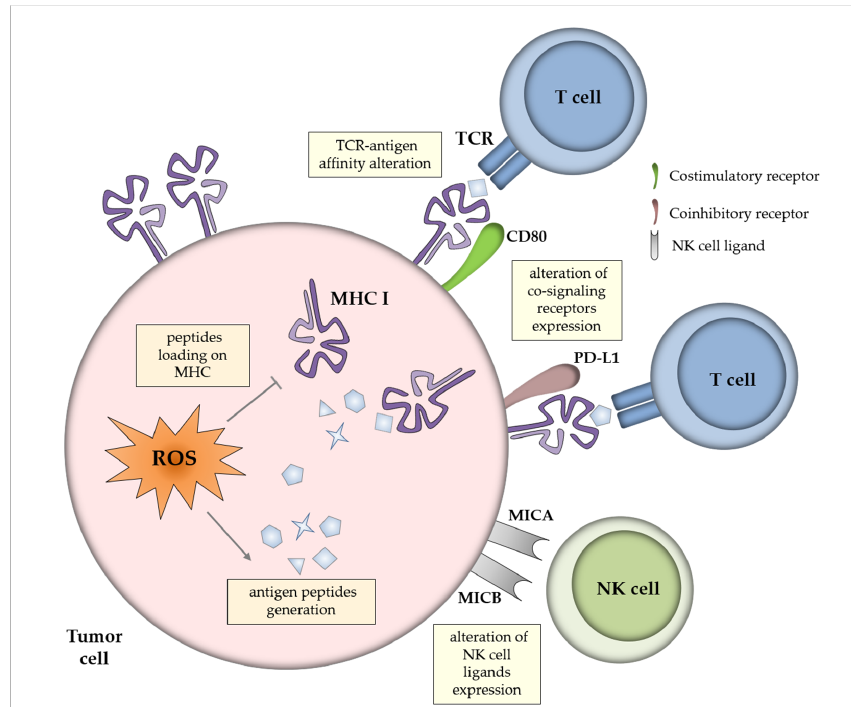
Figure 1. Impact of reactive oxygen species (ROS) on tumor antigenicity and immunogenicity. Oxidative stress in the tumor cells can induce the generation of antigenic peptides, which is counterbalanced by limited loading on major histocompatibility complex (MHC) molecules. Post-translational modification of proteins by ROS may alter antigenicity and modify T cell receptor (TCR) a ffi nity to antigens. In addition, ROS may regulate the expression of co-signaling receptors for T cells (i.e., CD80 costimulatory molecule and PD-L1 coinhibitory molecule) and of NK cell ligands (i.e., MHC class I chain-related protein A and B MICA and